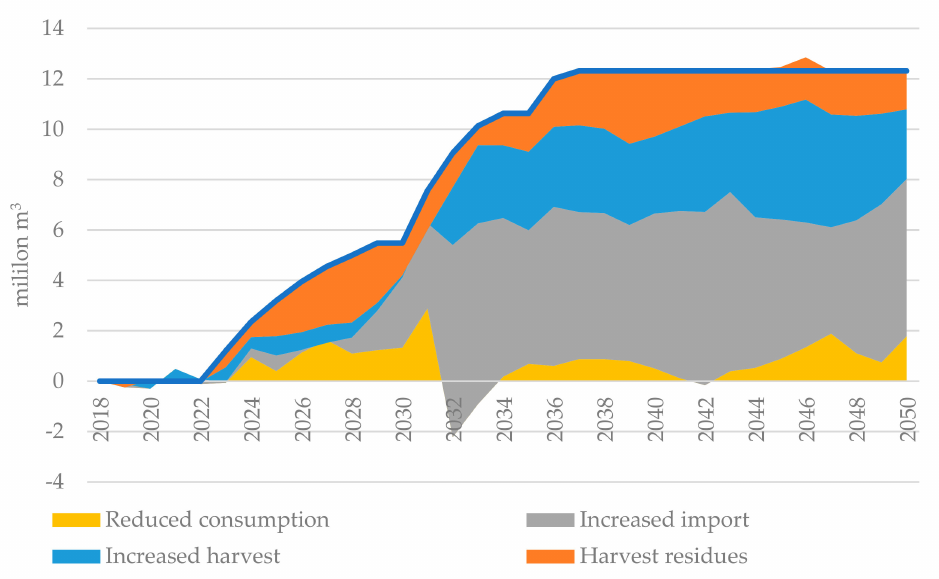
Figure 10. Change in harvest, use of harvest residues, and increased import (stacked) and forest raw material demanded for biofuel production in the Nordic countries. The figure shows the difference between the base and a similar scenario without biofuel production.